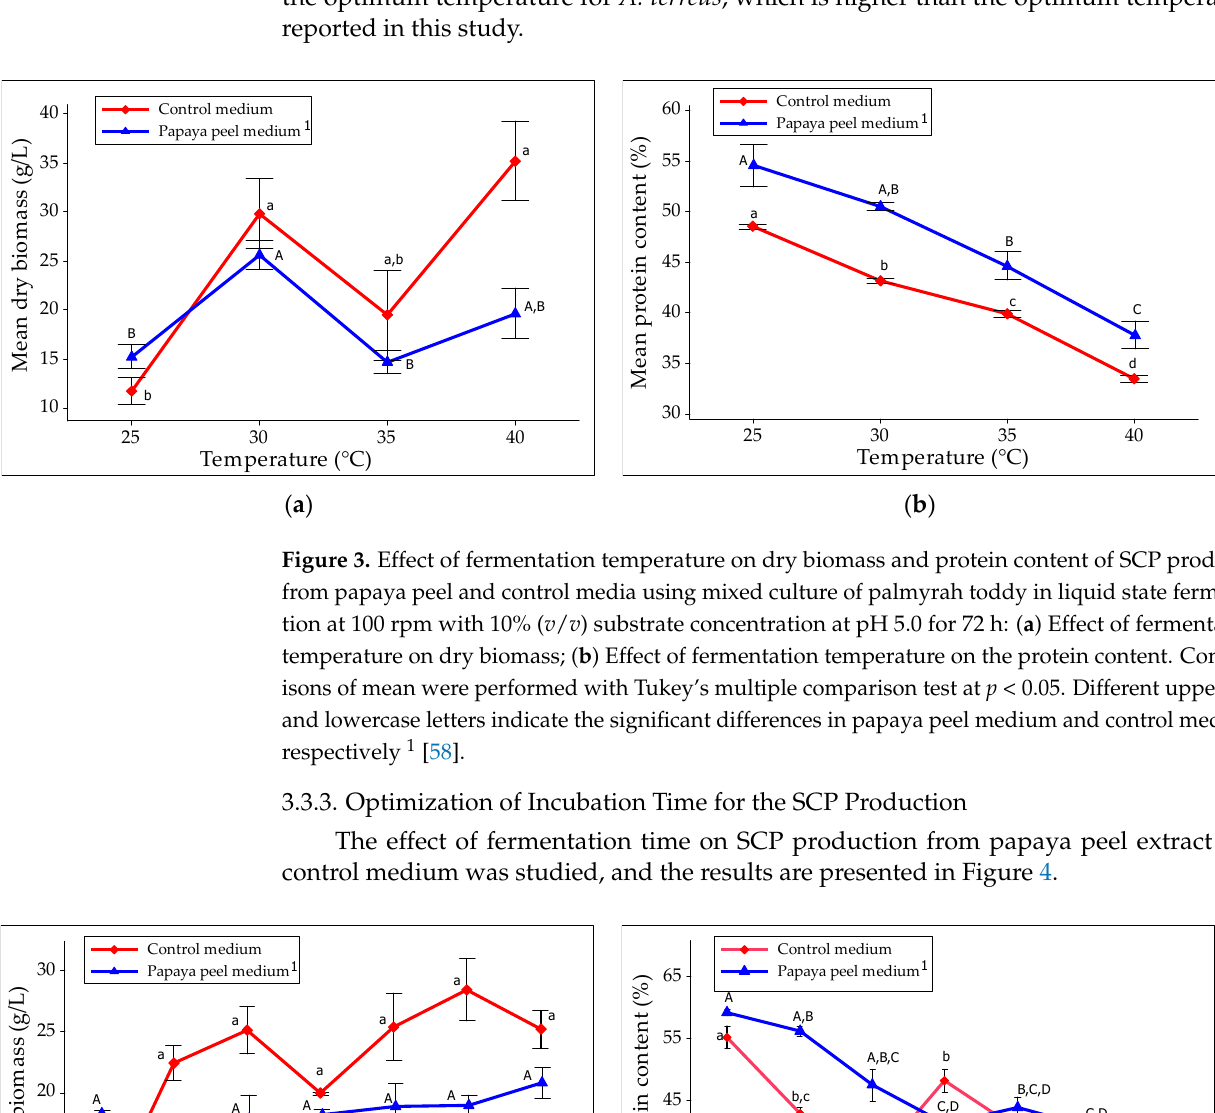
Figure 3. Effect of fermentation temperature on dry biomass and protein content of SCP produced from papaya peel and control media using mixed culture of palmyrah toddy in liquid state fermen- tation at 100 rpm with 10% ( v / v ) substrate concentration at pH 5.0 for 72 h: ( a ) Effect of fermentation temperature on dry biomass; ( b ) Effect of fermentation temperature on the protein content. Com- parisons of mean were performed with Tukey’s multiple comparison test at p < 0.05. Different up- percase and lowercase letters indicate the significant differences in papaya peel medium and control medium, respectively [58].